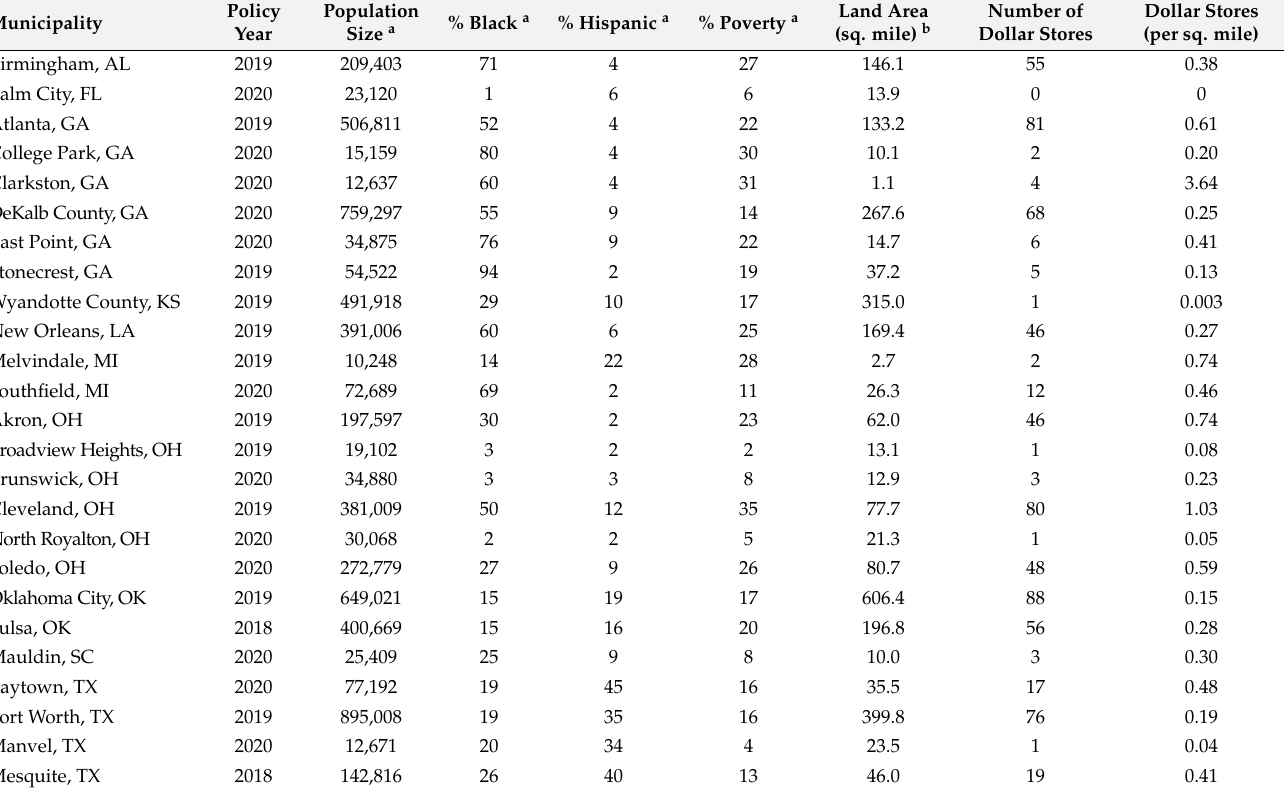
Table 2. Socio-demographic and environmental characteristics of municipalities (N =